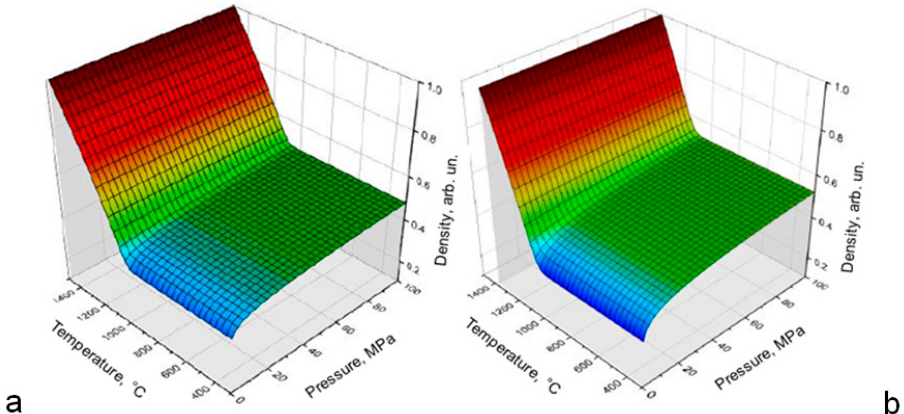
Figure 2. Compaction surfaces of yttrium-stabilized zirconia (YSZ) powder during consolidation by the SPS technique using various pressing schemes: ( a ) uniaxial pressing and ( b ) collector pressing.